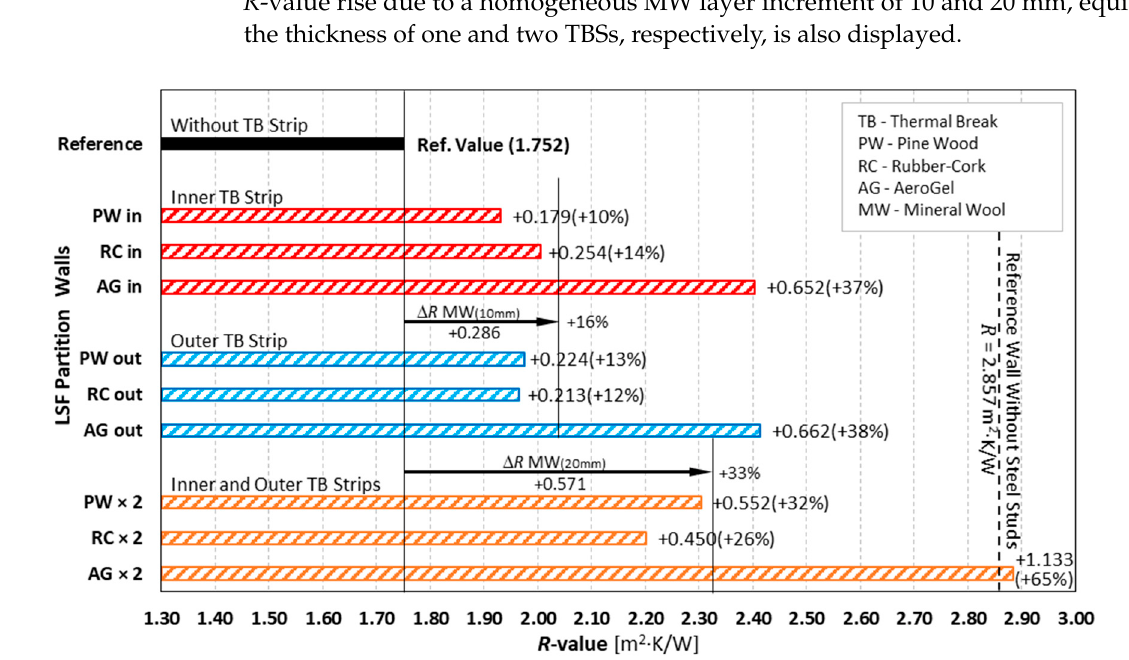
from +10% up to +14% and for double TBSs from +26% to +32%. However, the 𝑅 -values